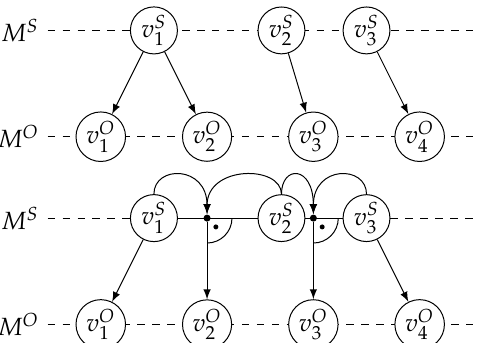
Figure 3. Comparison of the nearest-neighbour mapping ( top ) and the nearest-projection mapping ( bottom ). Both mappings are consistent and map from the search mesh M S to the origin mesh M O . The nearest-projection mapping prevents extrapolation by mapping to the closest vertex for v O The vertices v O and v O are projected onto the edges ( v S 2 3